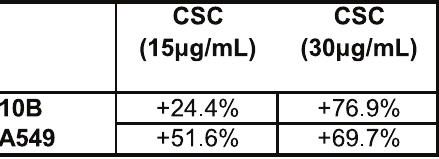
Figure 5. CSC treatment increases rate of mitoxantrone efflux. Flow cytometric analysis of intracellular mitoxantrone levels revealed significantly higher rates of extrusion in CSC-treated cells. Values shown are the percentage differences compared to non-treated samples.